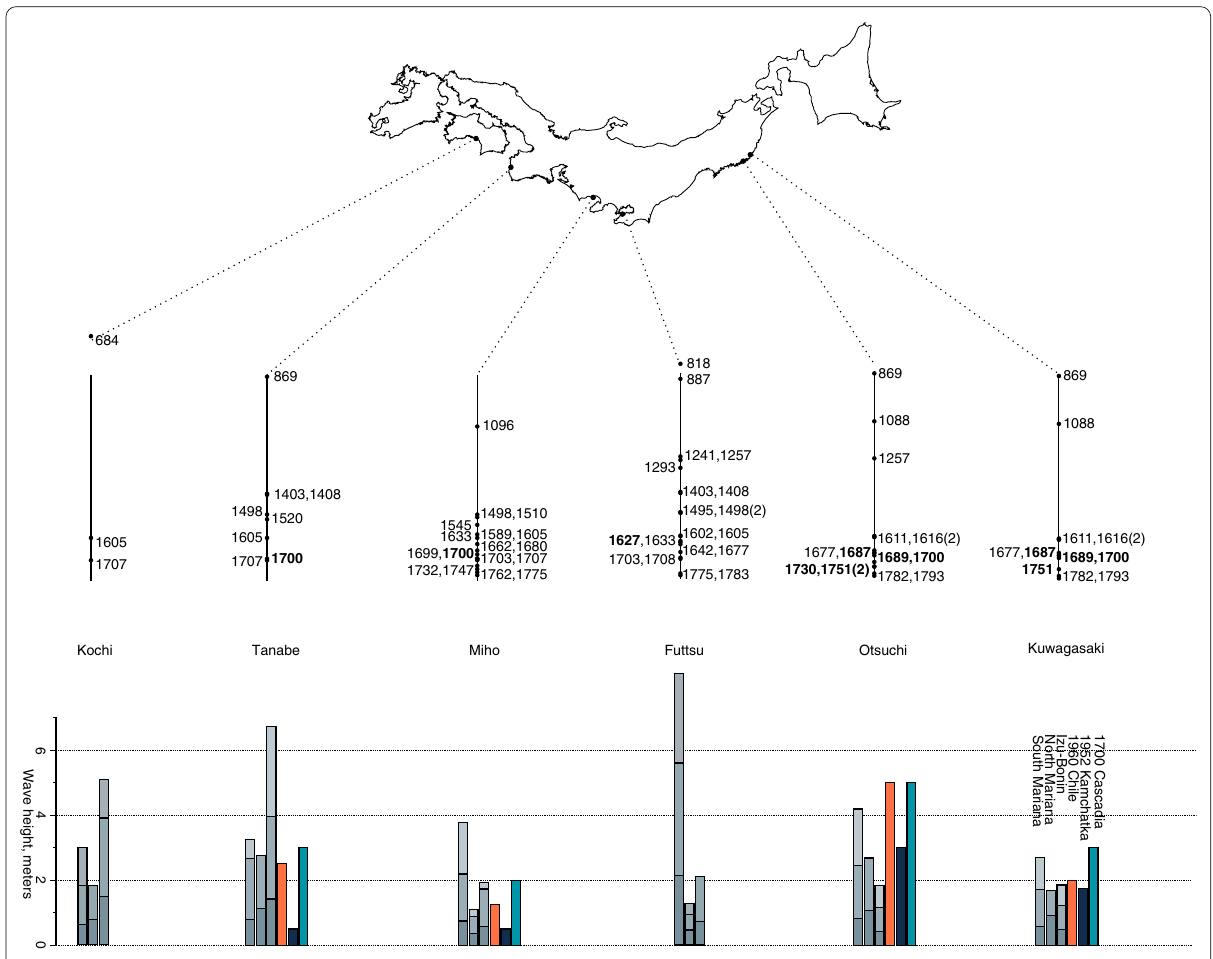
Fig. 4 Historical record of tsunami prior to 1800 with wave heights for select Japanese locations. Vertical lines denote times of written records of tsunami at each location. Bold values indicate orphan tsunami (i.e., tsunami without local shaking). All timelines end at the year 1800 and are to scale. Wave heights at select locations for tsunami sources in the Izu–Bonin, North Mariana, and South Mariana are from this work, while wave heights from the 1700 Cascadia tsunami (green), 1952 Kamchatka tsunami (dark blue), 1960 Chile tsunami (orange) are from Atwater et al., [2005]. Izu–Bonin, North Mariana, and South Mariana wave heights are stacked, showing tsunami wave heights from M w 8.7 earthquakes in dark gray, those from M w 9.0 earthquakes in gray, and those from M w 9.3 earthquakes in light